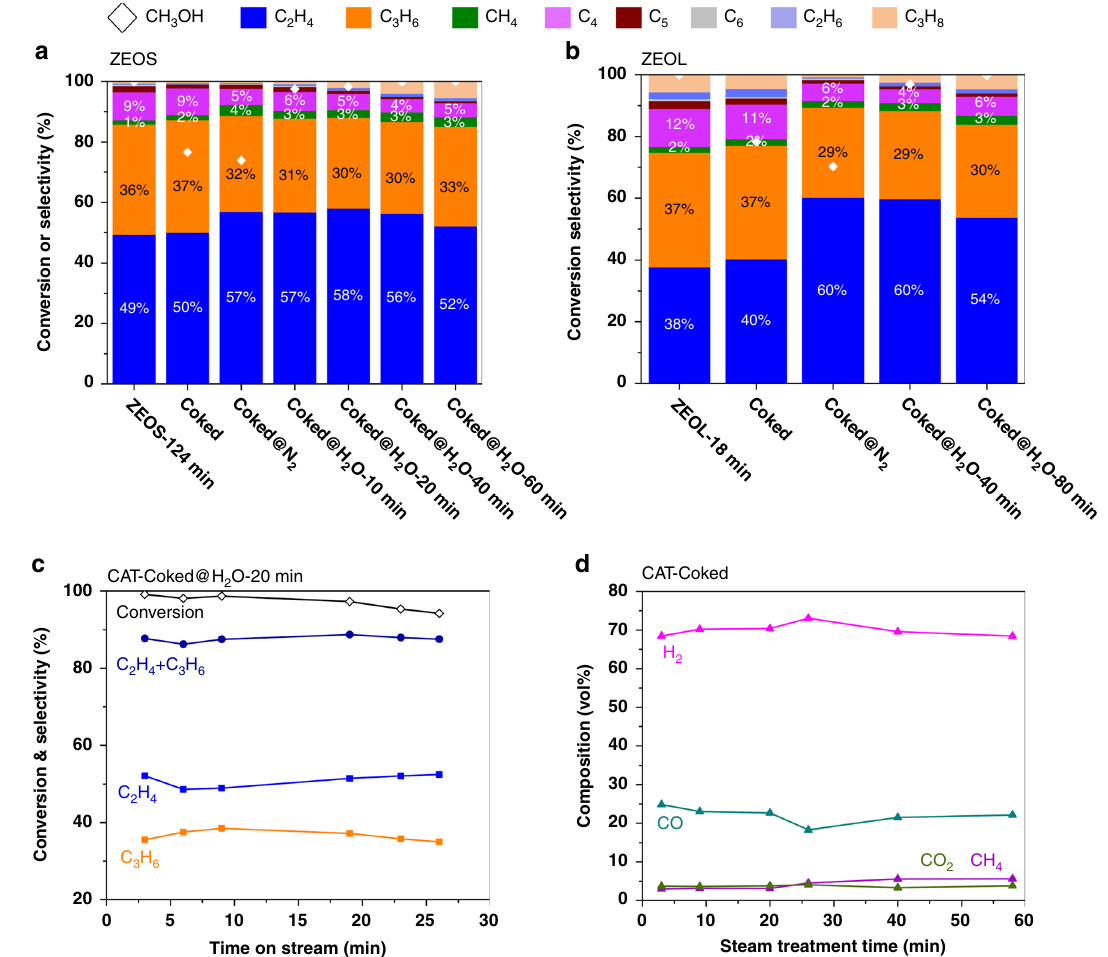
Fig. 3 Catalytic performances over naphthalene-based SAPO-34 zeolites in MTO reaction. a ZEOS and b ZEOL zeolites were used to implement the strategy of selective transformation of coke to naphthalene. MTO reactions were fi rst performed on calcinated SAPO-34 zeolites, the peak selectivity of ethylene and product distribution under completed conversion of methanol at 124 min for ZEOS sample (abbreviated as ZEOS-124 min) or at 18 min for ZEOL sample (abbreviated as ZEOL-18 min) are shown in the fi rst bar chart. When the methanol conversion decreased to ~80%, the product distribution is shown in the second bar (samples named as ZEOS-Coked and ZEOL-Coked). The initial product distributions of MTO reaction at ~1.5 min are shown in the followed bar charts over ZEOS-Coked and ZEOL-Coked samples treated by nitrogen at 953 K for 40 min (samples aliased as Coked@N 2 ) or steam cracking at 953 K for different times (samples aliased as Coked@H 2 O-xxmin series). MTO reaction condition: T = 723 K, weight hour space velocity (WHSV) = 6.6 g MeOH g cat. h − 1 . Steam cracking condition: T = 953 K, WHSV = 2.6 g Steam g cat. h − 1 . c MTO reaction performance over the CAT-Coked@H 2 O-20